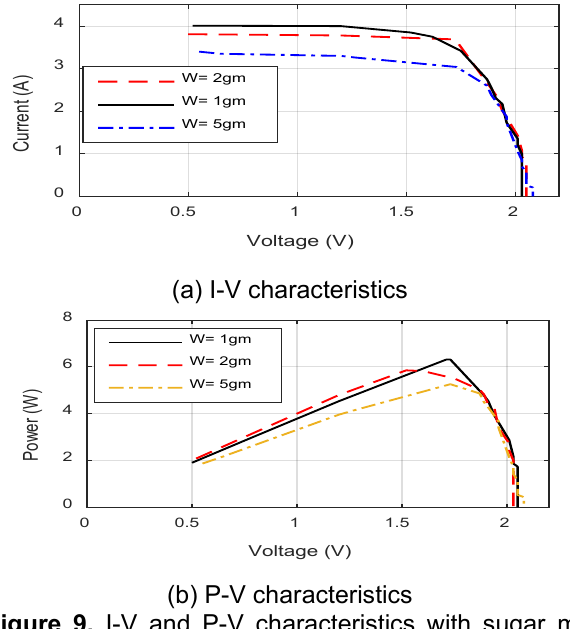
Figure 8. I-V and P-V characteristics with Brick furnace dust at 300 W/m 2